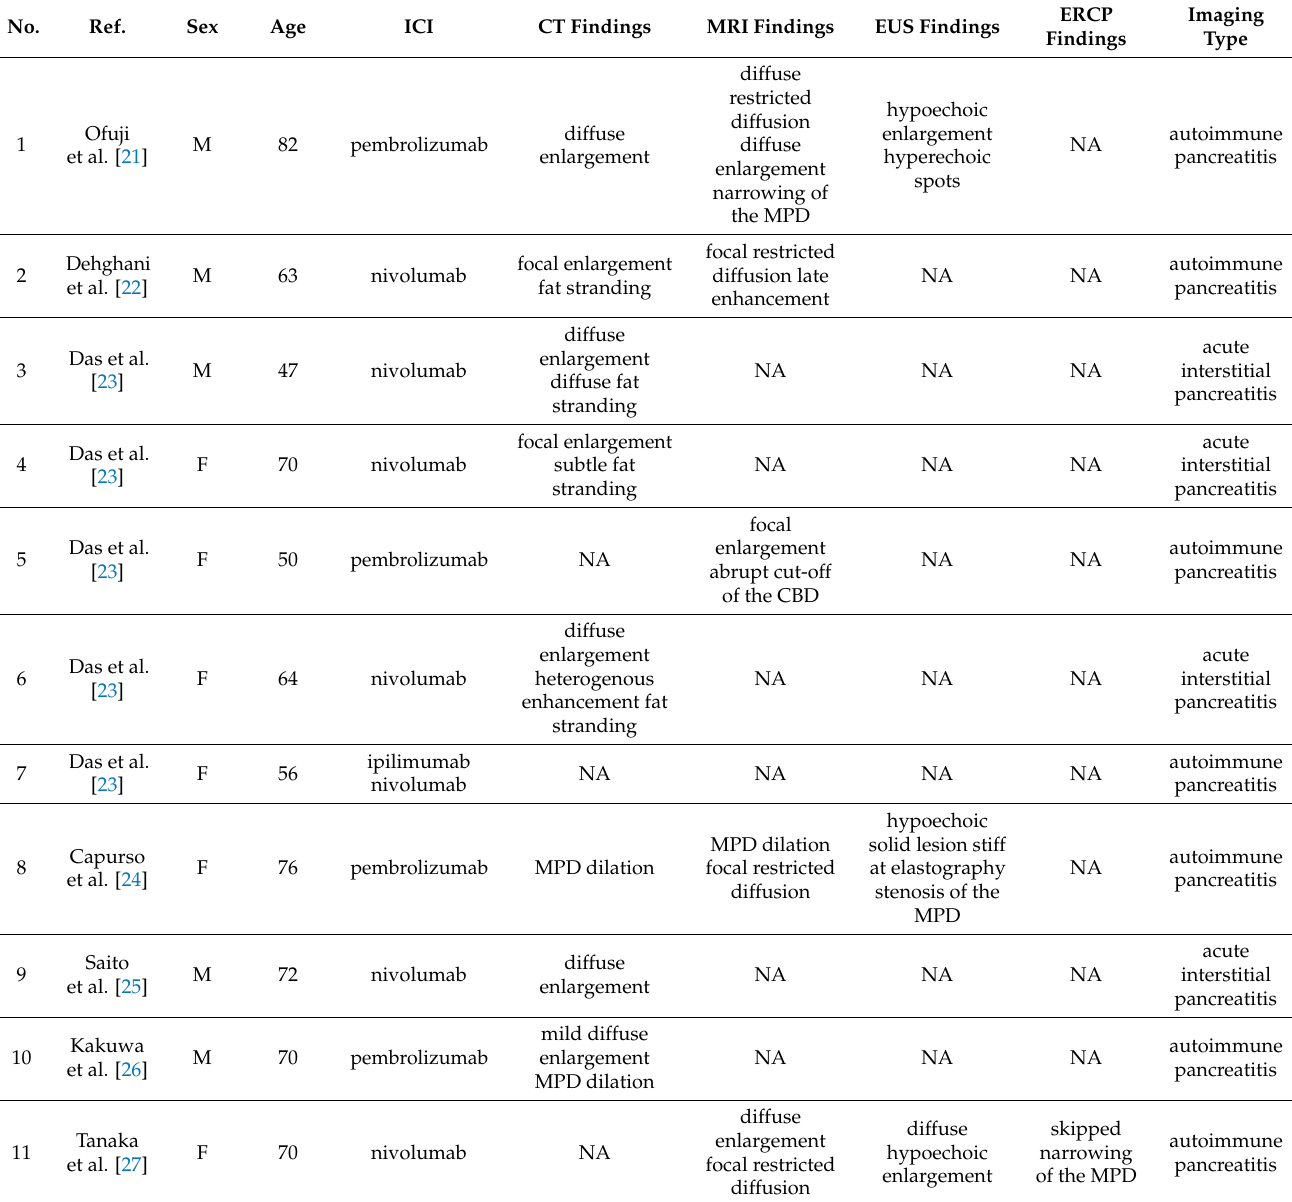
Table 1. Radiographic and endoscopic images of ICI-related